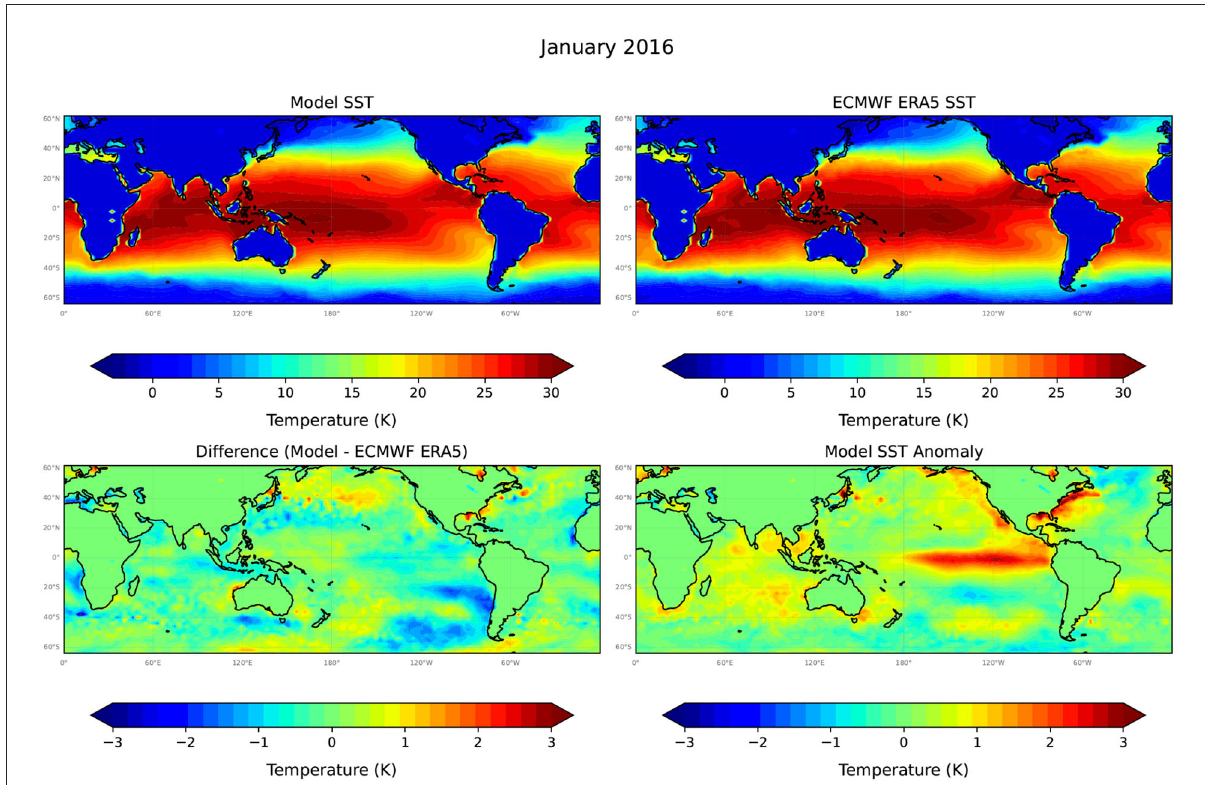
FIGURE4 The model predicted SST at +1 month (January 16), from a model forecast initiated in December 2015, the corresponding target ERA5 SST data set, the difference between the model predictions and the target, and the model predicted SST anomaly. Note the different, much higher resolution temperature scale used to plot model differences and SST